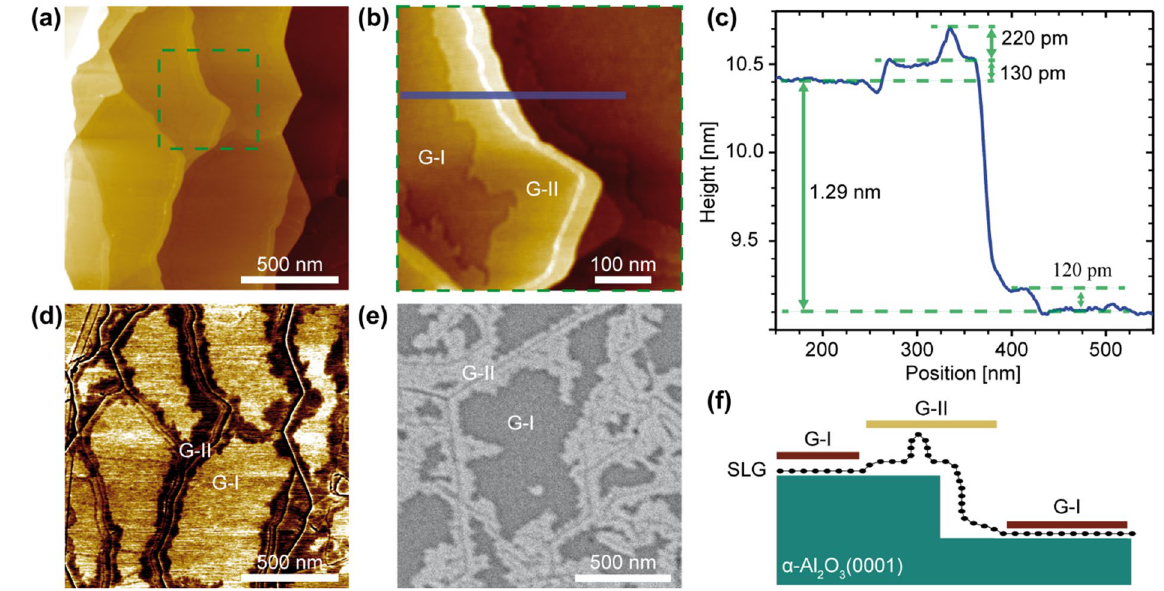
Figure 3. AFM and SEM measurements of SLG on α-Al 2 O 3 (0001). ( a ) Large area AFM image showing the edges of the sapphire steps. ( b ) Higher resolution image of the area marked in ( a ) (green square) showing an α-Al 2 O 3 (0001) step and wrinkles near the step edges. ( c ) Cross-section averaged over several lines along the blue bar in ( b ) showing a sapphire step edge of about 1.29 nm. Near the step edge, the SLG is elevated 120 pm to 130 pm from the terrace. ( d ) Corresponding phase image to ( a ). ( e ) SEM image. ( f ) Schematic of delamination near the step edges of sapphire. Two SLG regions an be seen, one on flat sapphire terraces and the other in the vicinity of sapphire step edges; they are labeled G-I and G-II, respectively, in ( b )–( f